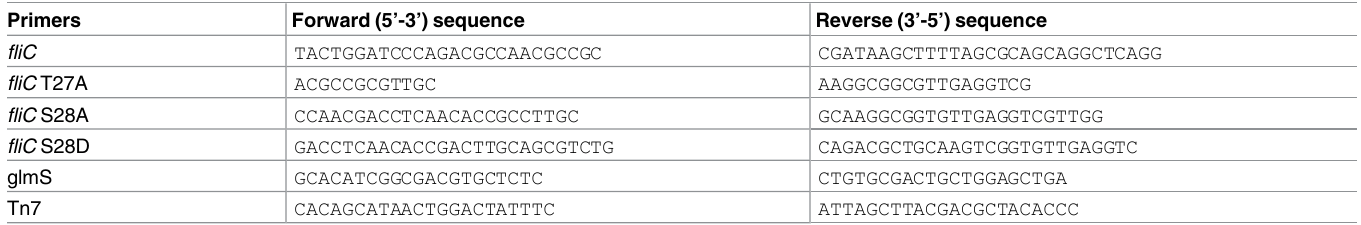
Table 2. List of primers used for generating